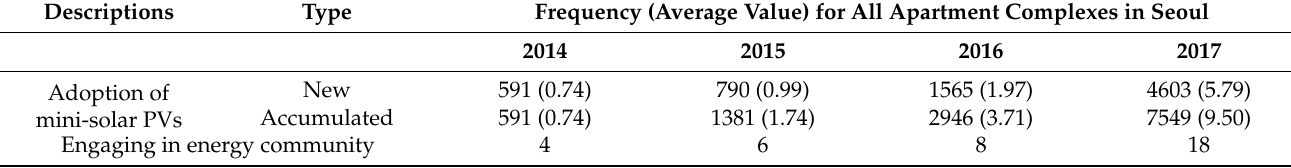
Table 2. Adopters of mini-solar PVs engaging in the energy community